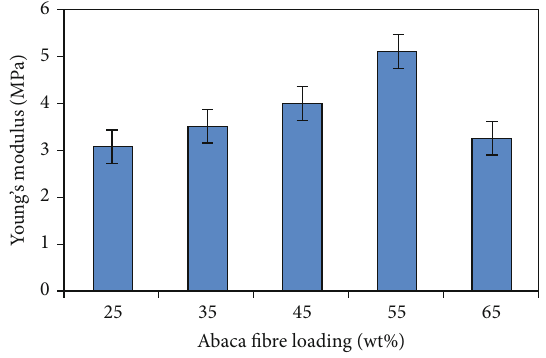
Figure 5: Young ’ s modulus (GPa) vs abaca fi bre loading (wt %).